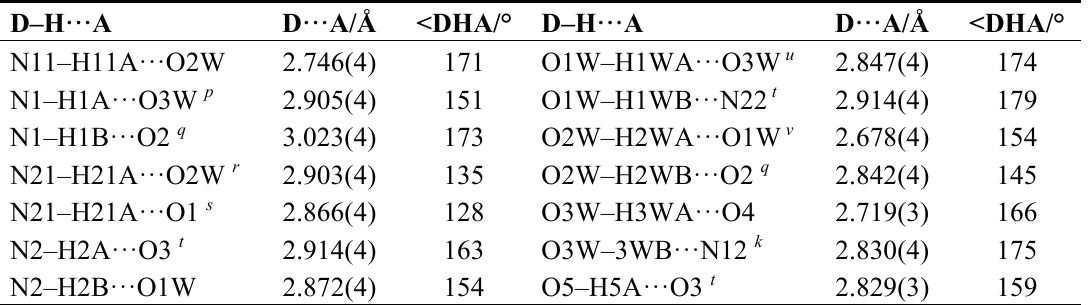
Table 4. Geometrical details on the hydrogen bonds present in compound [Fe 2 (Hatrc) 4 (OH) 2 ]·6H 2 O ( 3 ).